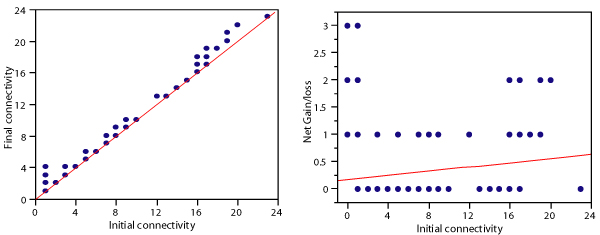
Acquisition of protein links and test of preferential attachment. Left panel. The relationship between the connectivity of a gene present at the root of the tree and its connectivity in the yeast (S. cerevisiae). Based upon 295 genes present at the root and in yeast. Line is 1:1 relationship. Right panel. The relationship between the number of connections acquired between the root of the tree and yeast (final-initial connectivity) and initial connectivity. Preferential attachment predicts a positive relationship. The regression line is positive but the weak relationship (r2 = 0.03, slope = 0.018, p < 0.004), is not sufficient to produce a power-law scaled network (see text).